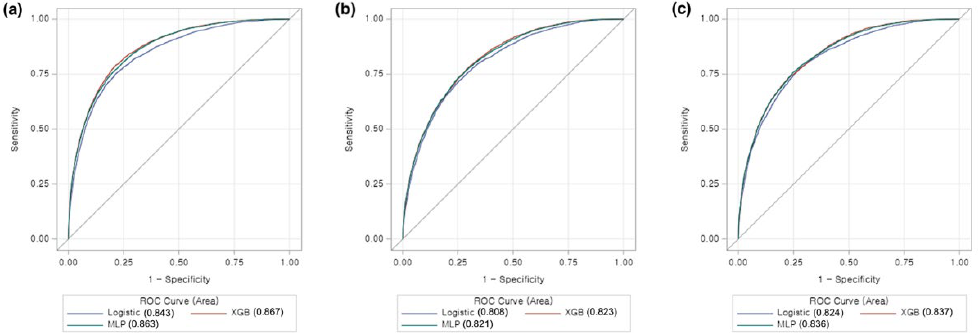
Figure 4. Receiver operating characteristic curves of A-type models with Dataset 1 ( a ) and Dataset 2 ( b ), and B-type models with Dataset 2 ( c ) (ROC: receiver operating characteristic; XGB: Extreme gradient boosting; MLP: Multilayer perceptron).